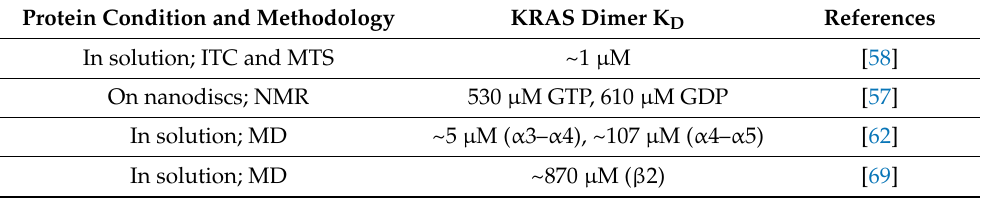
Table 2. KRAS binding affinities. Protein Condition and